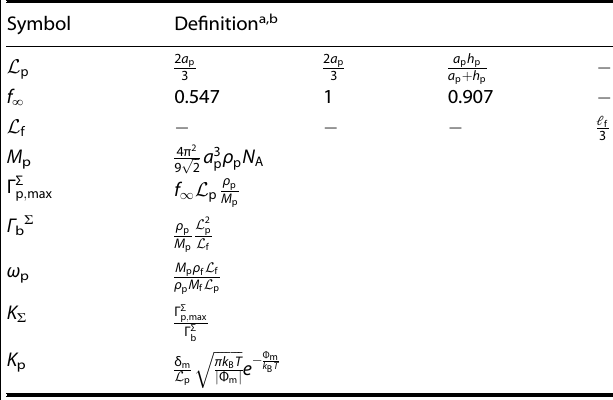
Table 4. De fi nitions, necessary for the calculation of the surface